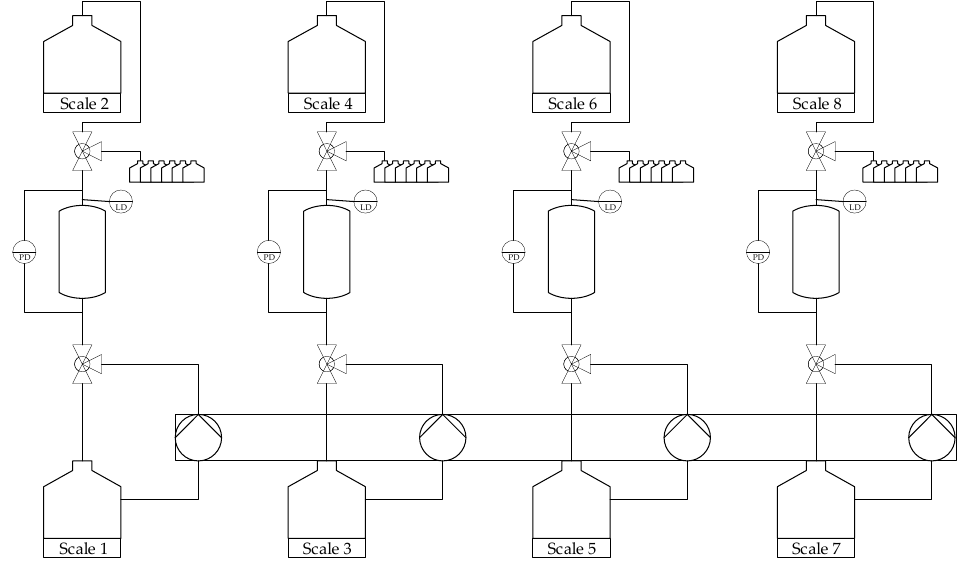
Figure 8. Multi-column extraction apparatus for automated process characterization of process sequences consisting of maceration and percolation stages.